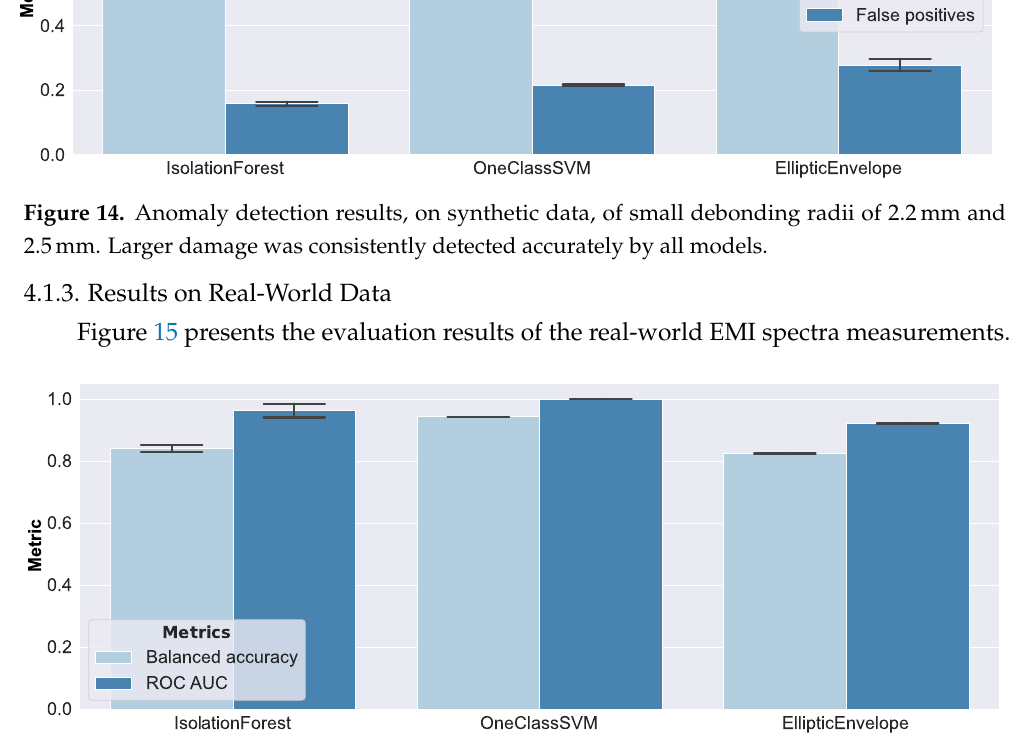
Figure 15. Anomaly detection results on real-world data.